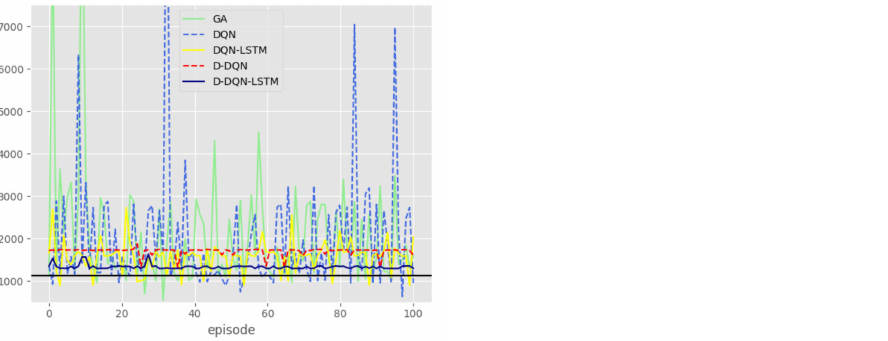
Figure 9. Comparison of the path length of 5 algorithms running 100 times in the same environment.